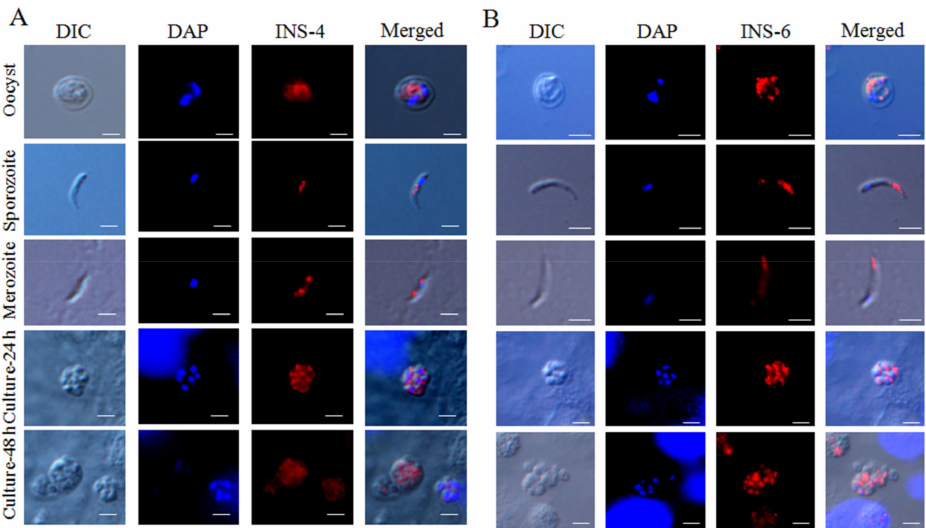
Figure 5. Expression of INS proteins in life cycle stages of Cryptosporidium parvum . The expression of CpINS-4 ( A ) and CpINS-6 ( B ) on C. parvum oocyst (top panel), sporozoites (second panel), merozoites (third panel) and intracellular developmental stages in HCT-8 cell cultures at 24 h (fourth panel) and 48 h (bottom panel) was assessed by immunofluorescence using the polyclonal antibodies generated. The images were taken under differential interference contrast (DIC), with nuclei being counter- stained with 4 (cid:48) , 6-diamidino-2-phenylindole (DAPI), parasites stained by immunofluorescence assay with anti-INS antibodies, and superimposition of the three images (Merged). Scale-bars: 2 µ m for all